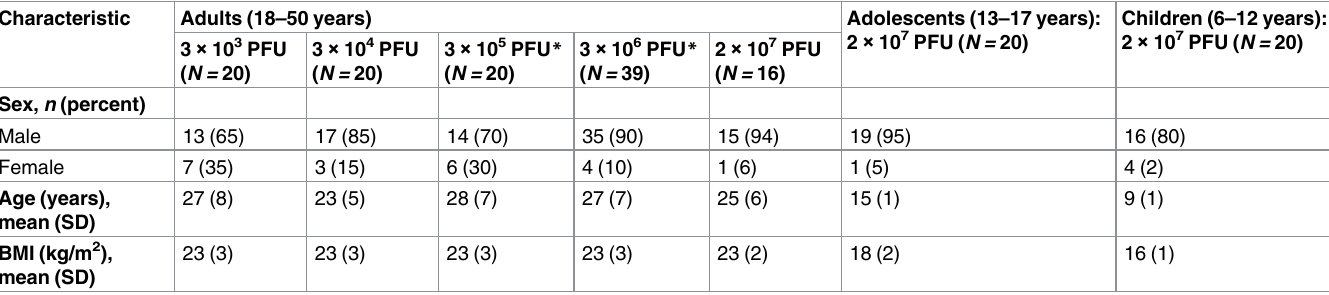
aged 6–12 years were vaccinated with 1 intramuscular dose of 2 × 10 7 PFU. Adolescents and children reported mostly headaches, fatigue, pain at injection site, gastrointestinal symptoms, and subjective fever. All reported symptoms were of mild (81% adolescents, 82% children) to moderate (19% adolescents, 18% children) intensity (Table 2). As in adults, a general reduction in leukocyte counts was observed in adolescents and chil- dren within the first 2 days post-injection; leukocytes gradually restored to baseline values by day 28. An increase in monocyte and lymphocyte counts was observed between days 2 and 7, Table 1. Baseline characteristics of study participants.